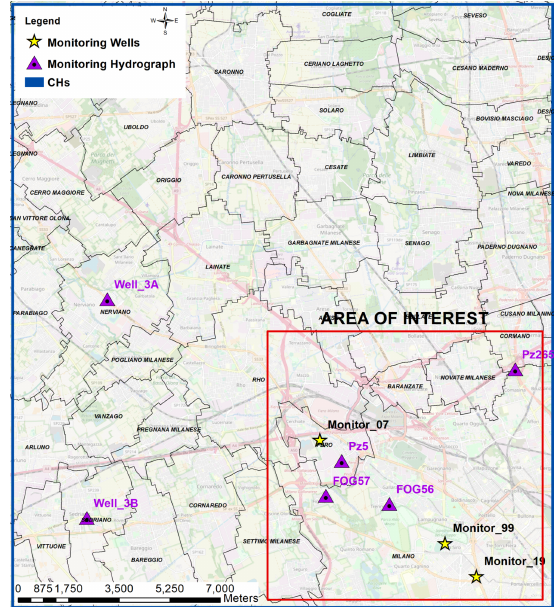
Figure 6. Monitoring wells and Monitoring hydrographs location in the model